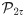
Example partitioning of the matrix to test conditions 3a-c.The left panels show an example of g
(1) and g
(2) and P2τ. Note that g
(2) has two stable and two unstable fixed points. The partition of P2τ shown in the right panel with dashed lines can be determined from a given choice of α. We note that the matrix has been flipped in the vertical direction to emphasize the correspondence between P2τ and g
(2)(θ) so that in this visual example, matrix multiplication would not be performed in the usual way. From left to right, the submatrices denoted with asterisks are defined to be P2τn2+→u1, P2τu2→u1, and P2τn1-→u1. From top to bottom, the regions submatrices denoted with dots are defined to be Pmτu1→n1-, Pmτu1→u2, and Pmτu1→n2+. The steady state distribution calculated as the right eigenvector of P2τ associated with λ = 1 is shown to the right of P2τ, along with the associated partition. Note that because the conditions guaranteeing clustered desynchronization are satisfied, by taking ϵ small enough, the difference between the amount of the steady state population found in s
1 and s
2 can be made arbitrarily small.